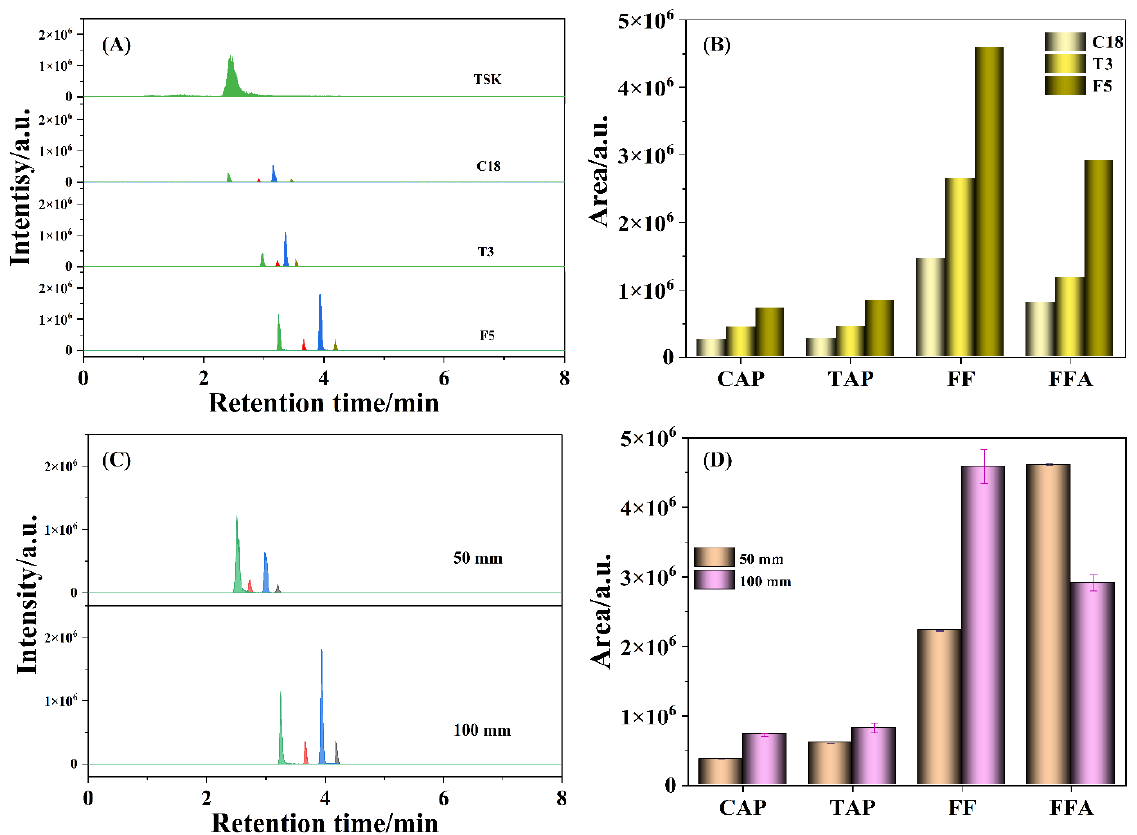
Figure 2. The chromatograms ( A ) and histograms ( B ) of peak areas for various chromatographic columns, the chromatograms ( C ) and histograms ( D ) of peak areas for different F5 chromatographic column length. Amphenicol standard solution: 50 ng/mL; mobile phases: 10 mM ammonium acetate and methanol; peaks from left to right: FFA, TAP, FF, and CAP.